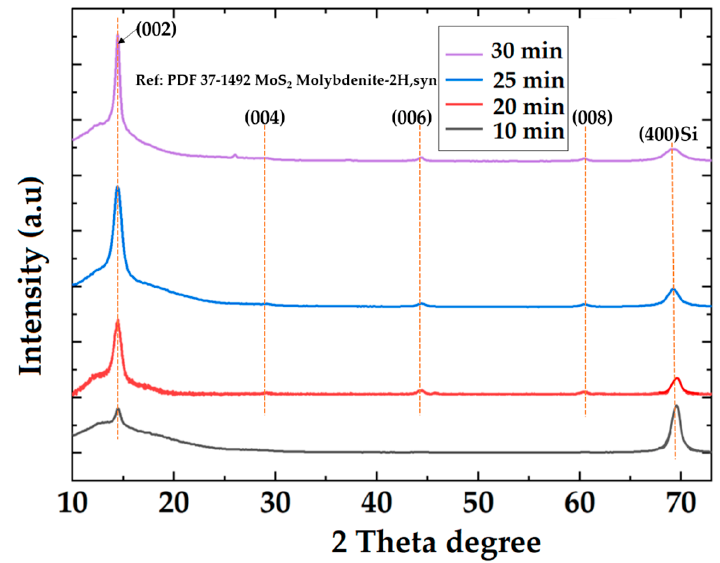
Figure 3. XRD analysis of synthesized MoS 2 at different deposition times.